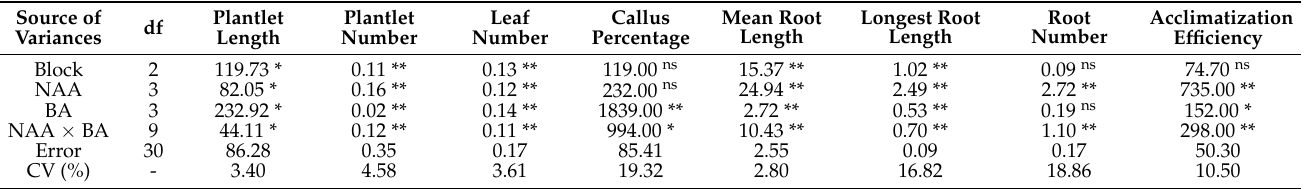
Table 2. Analysis of variance of the effect of different concentrations of NAA and BA on the measured characteristics of Zamioculcas zamiifolia (Lodd.) Engl. ‘Dowon’ grown in vitro in the multiplication, rooting, and acclimatization steps.